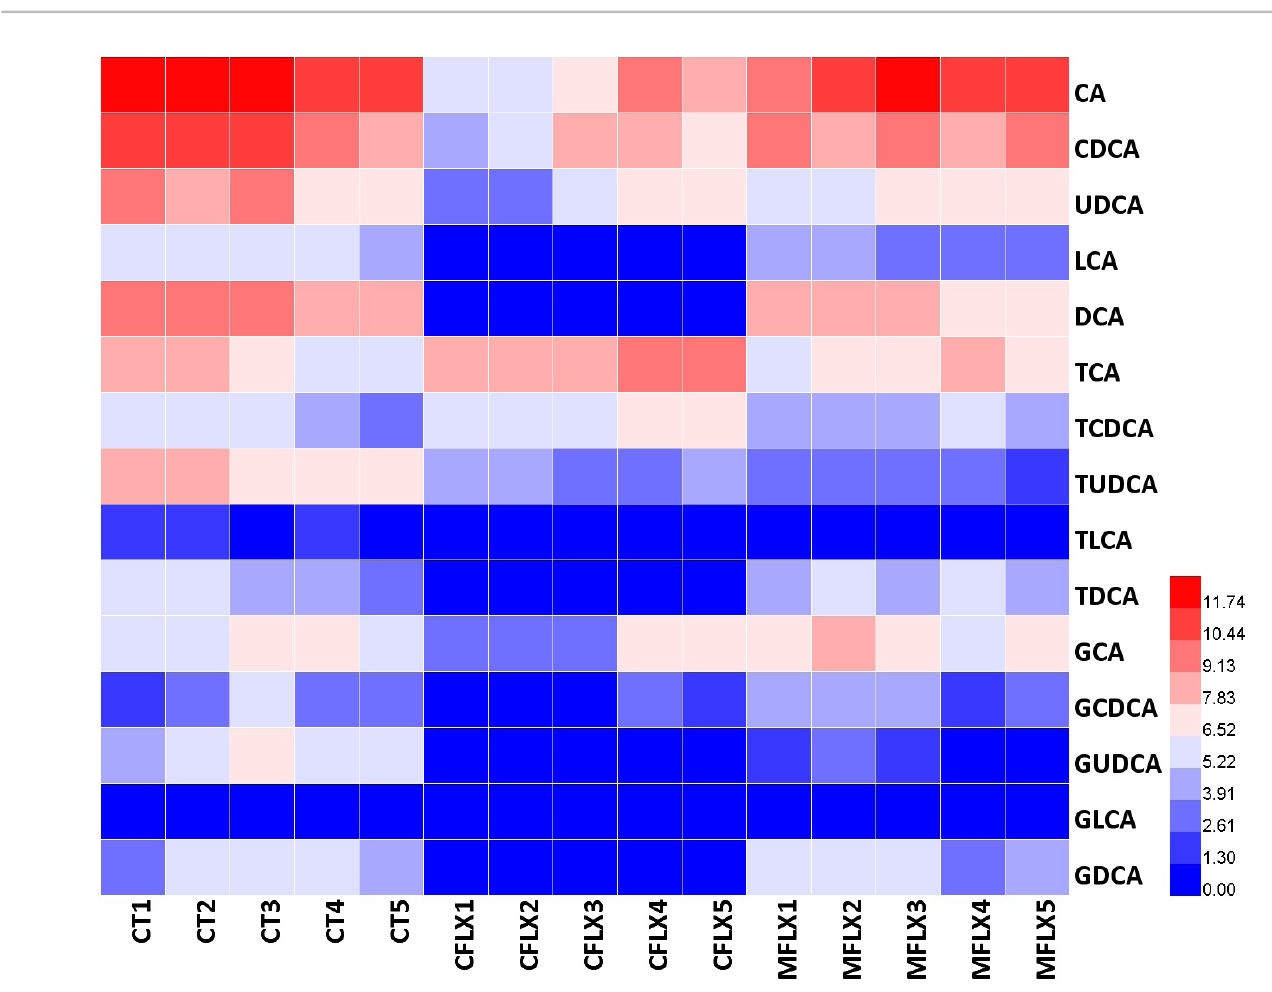
FIGURE 2 - Heatmap of the effect of ciprofloxacin and moxifloxacin on host BA profiles in serum of normal rats treated with 100 mg/kg/day ciprofloxacin and 40 mg/kg/day of moxifloxacin orally for seven days. The heatmap was generated using HemI 1.0.3.7. Red indicates an high value, whereas blue indicates a low